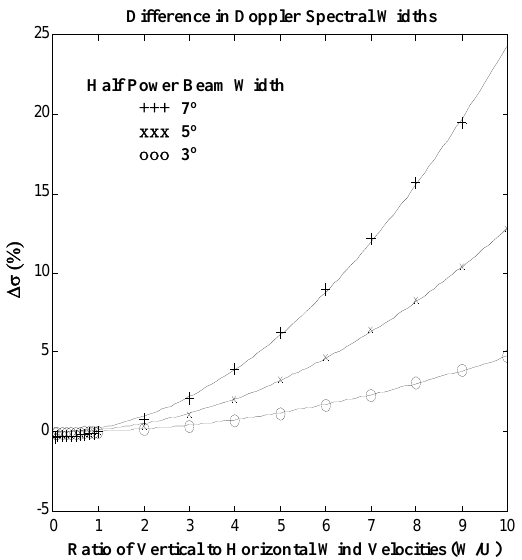
Fig. 8. Differences between spectral widths estimated from Doppler spectrum subject to horizontal wind in combination with vertical winds and a Gaussian beam broadening spectrum caused by hori- zontal wind